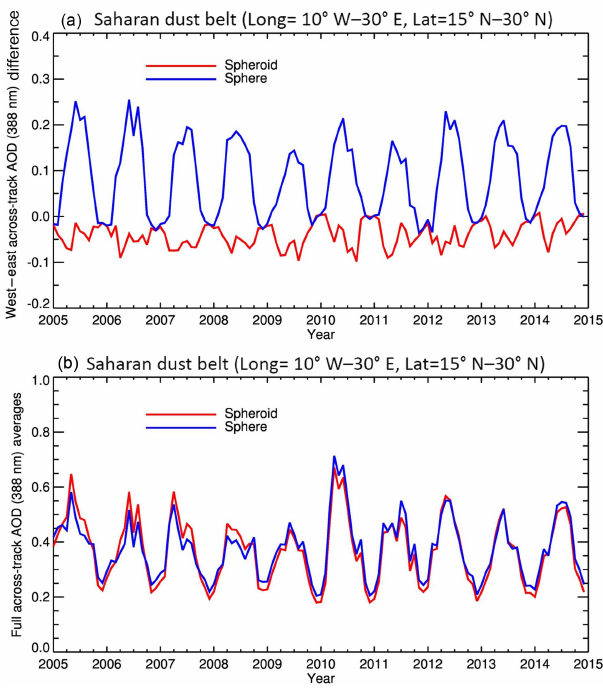
Figure 14. Panel (a) : difference between monthly averages of AOD calculated separately from west and east across-track OMI obser- vations for spherical (blue line) and spheroidal (red line) aerosol particles over the SAH region. Panel (b) : monthly average AOD calculated using all available across-track